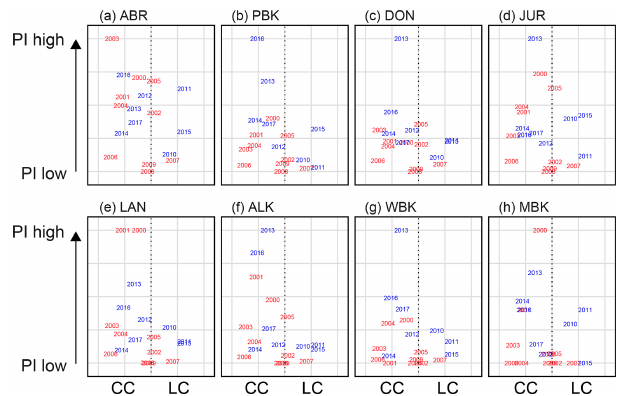
Figure 14. Relationship of the more dominant current during the late summer–early autumn (December–March) to late PI at moni- toring sites (a) Abrolhos, (b) Port Gregory, (c) Dongara, (d) Jurien Bay, (e) Lancelin, (f) Alkimos, (g) Warnbro, and (h) Cape Mentelle. The x axis is the difference between the LC and CC standardized, indicating which is more prominent at the time. Red indicates the seasons before the recruitment failure; blue indicates seasons